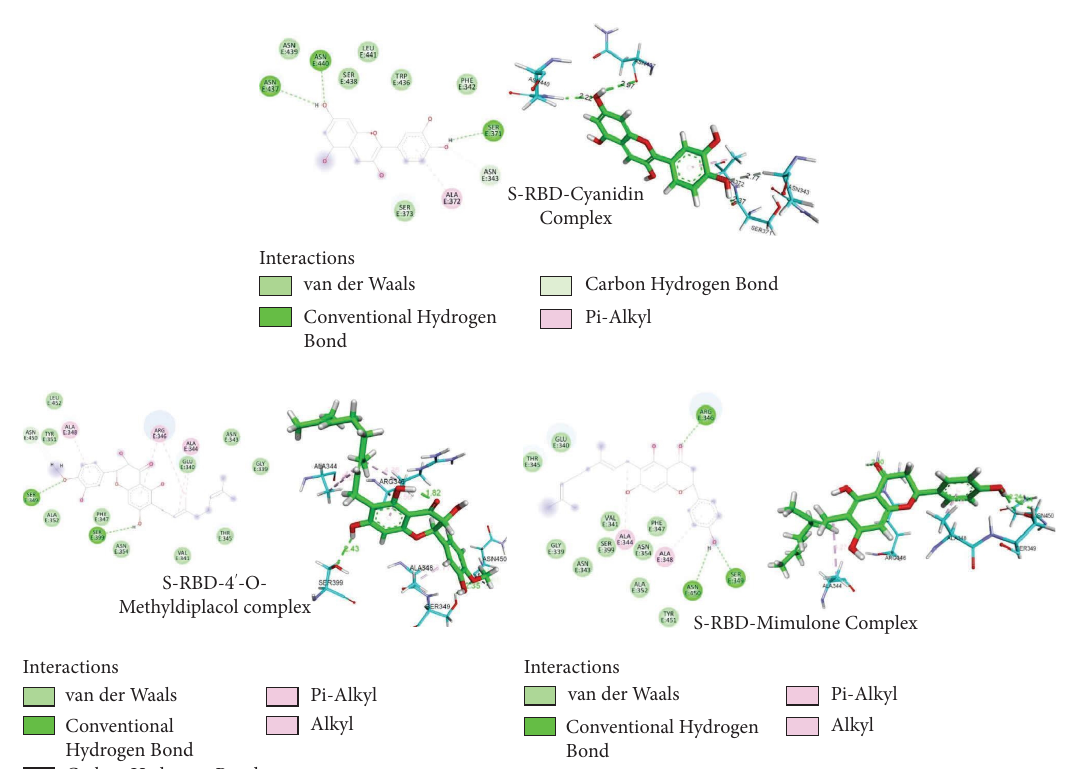
Figure 3: 2D and 3D structures of cyanidin, 4 ′ -O-methyldiplacol, and mimulone complexed with SARS-CoV-2 spike